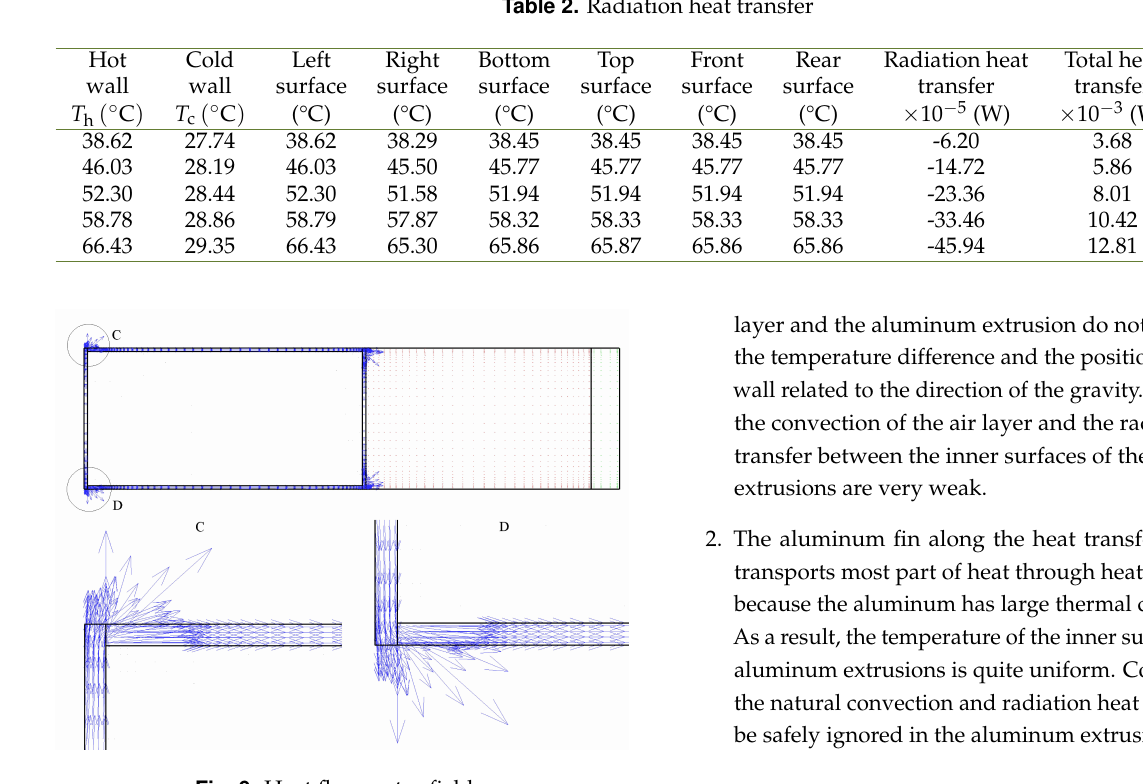
Fig. 9. Heat flux vector